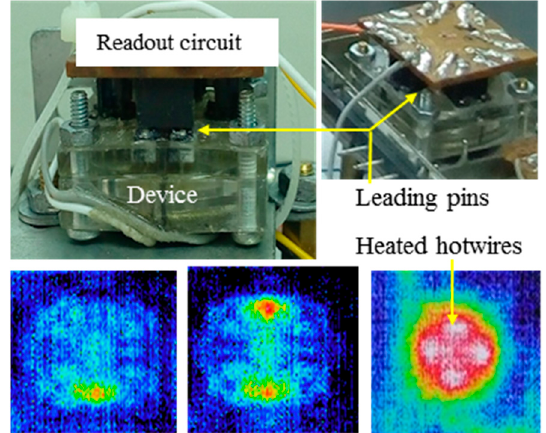
Figure 6. Experimental setup to confirm flow characteristics. The device was packed and connected to a readout circuit. The insets show a thermal image of the heated hotwires in each chamber before the device was packed (red: highest temperature).